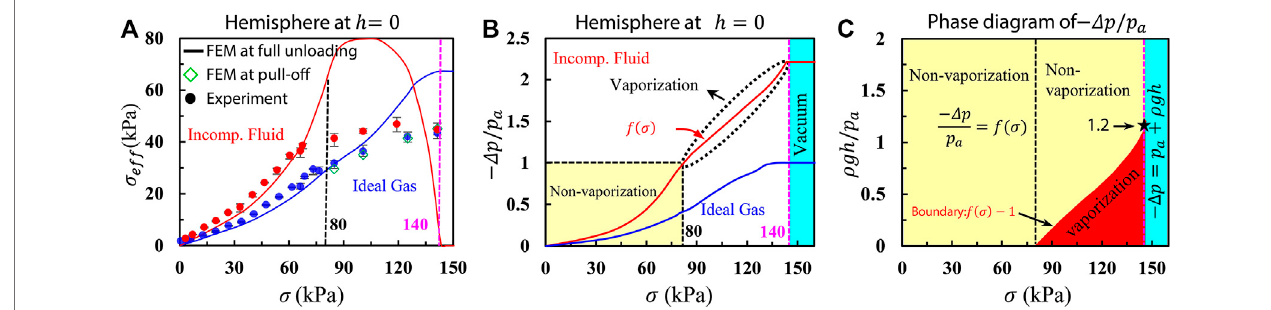
FIGURE 7 | Experimental and modeling results for craters underwater. (A) Effective adhesive strength σ eff as a function of preload σ for craters in air (blue) and underwater (red). Curves are FEM results at the unloading point. Solid markers are experimental results and open diamond markers are FEM results at the pull-off point. (B) Pressure drop as a function of preload σ . For craters fi lled with liquid, when internal pressure approaches zero, rapid vaporization can happen at room temperature, which violates the incompressible fl uid assumption. (C) Phase diagram of pressure drop as a function of liquid depth h and preload σ . [reprinted with permission from (Qiao et al.,